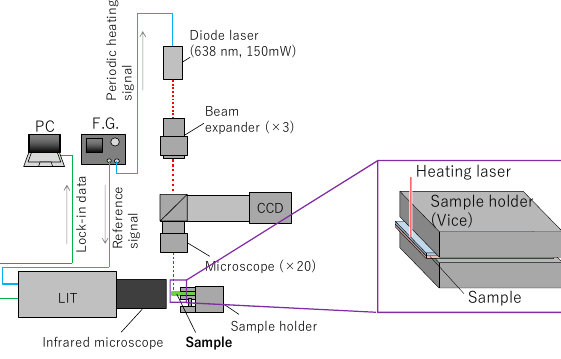
Figure 3. Schematic of TCR measurement